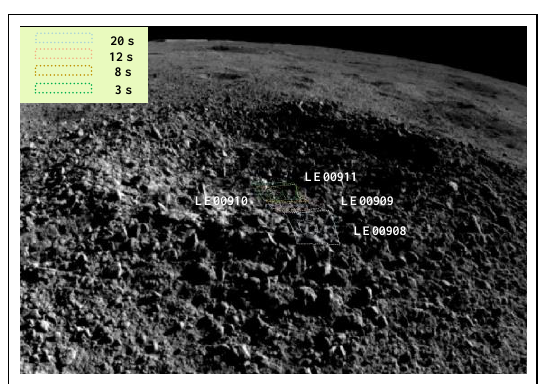
Figure 13. Predicted VNIS FOVs on Hazcam image of the four